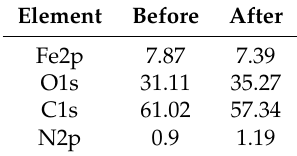
Figure 3. X-ray photoelectron spectroscopy (XPS) of PE–FeO x films sputtered for 60 s before and after bacterial inactivation under solar simulated light (52 mW cm − 2 ). Reprinted with permission from [35]. Copyright 2015 RSC. Table 1. Surface atomic percentages concentration determined by XPS on PE–FeO x sputtered for 60 s before and after bacterial reduction under solar irradiation (52 mW cm − 2